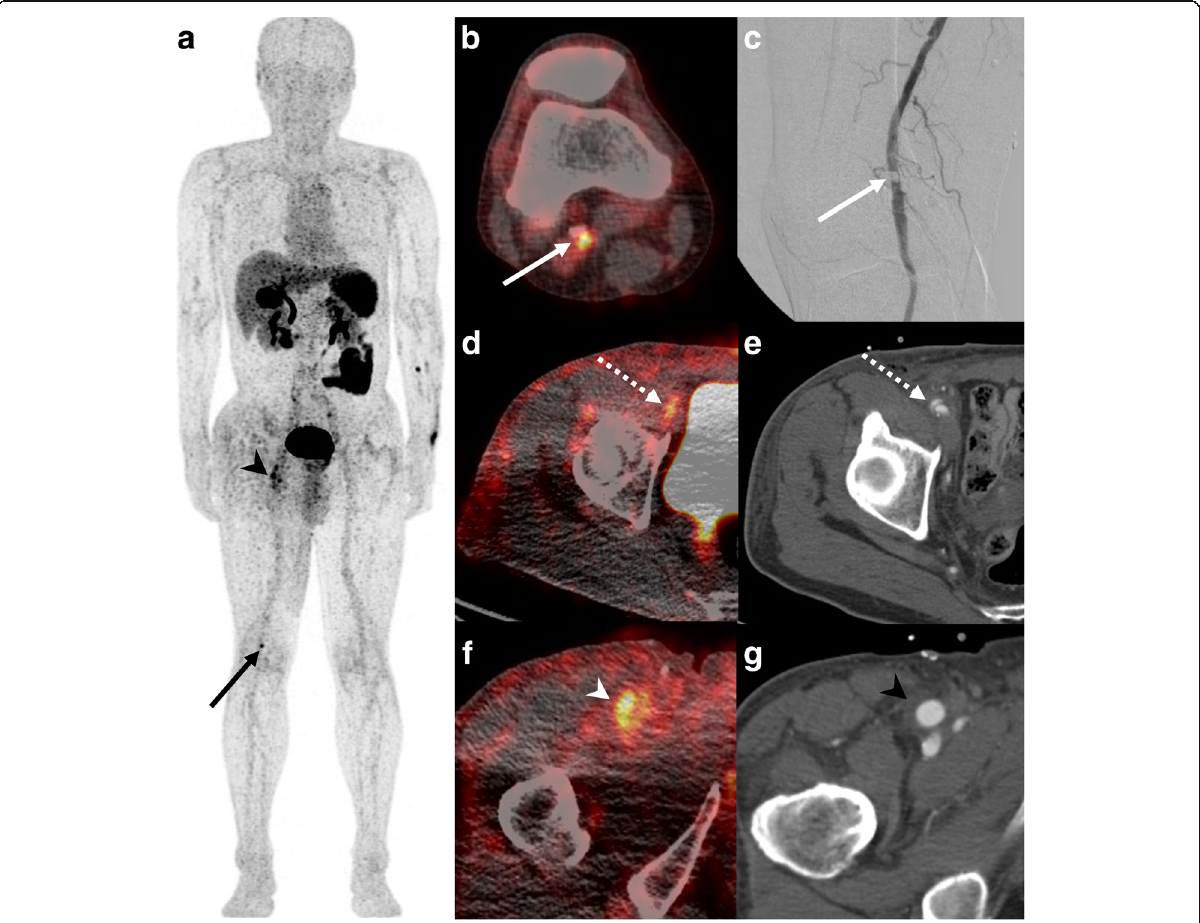
Fig. 4 18 F-GP1 PET/CT images of a 63-year-old man with right common femoral artery endarterectomy and right popliteal artery angioplasty. Anterior maximum intensity projection and transaxial images of 18 F-GP1 PET/CT at 120 min after injection show a focal increased uptake in the right popliteal artery ( a , b ; arrows), which corresponds to the AAT lesion after angioplasty ( c ). Additional positive 18 F-GP1 uptake is observed in the dissected right distal external iliac artery ( d , e ; dotted arrows) and right common femoral artery ( a , f ; arrow heads) where endarterectomy was performed due to occlusion 3 days before 18 F-GP1 PET/CT ( g , arrow